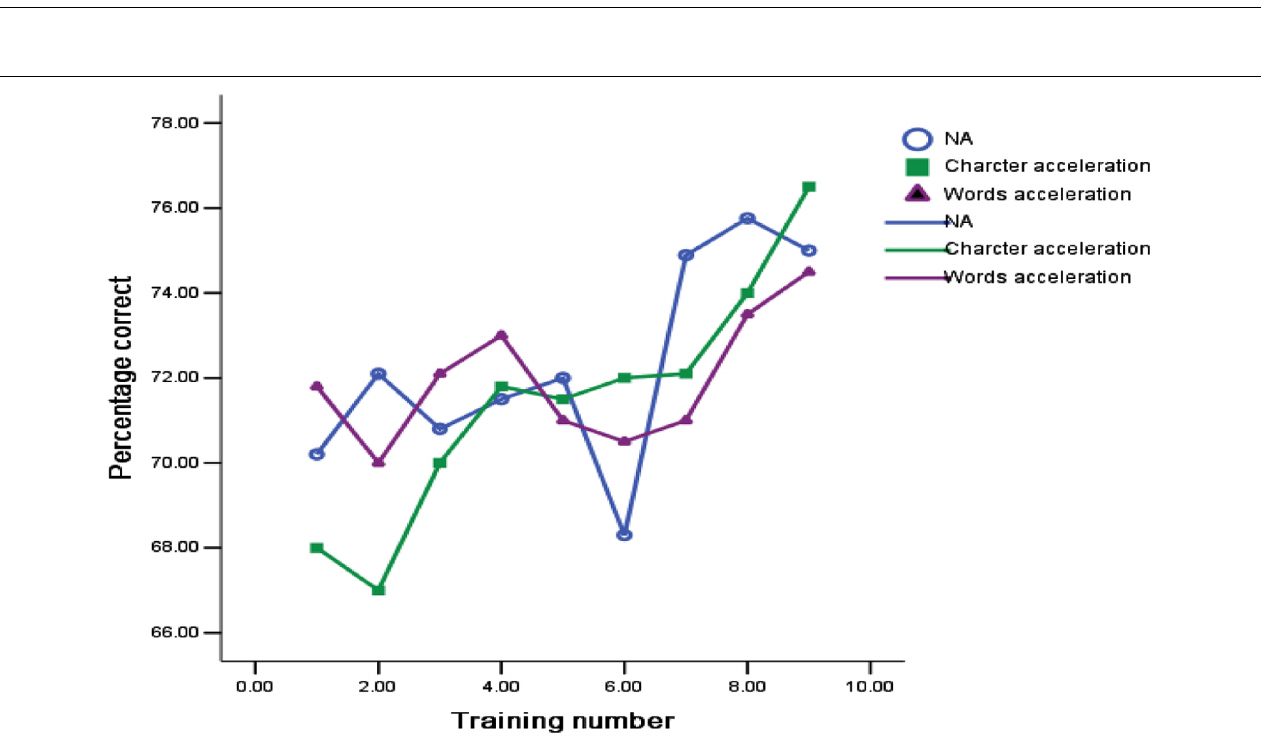
FIGURE 2 | The change of Chinese children with RD’s reading comprehension accuracy in the training process of three different accelerated reading groups.